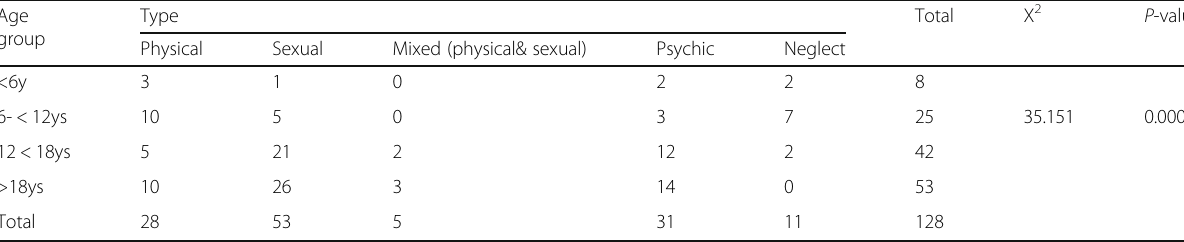
Table 3 Relation between age groups and type of violence Age group